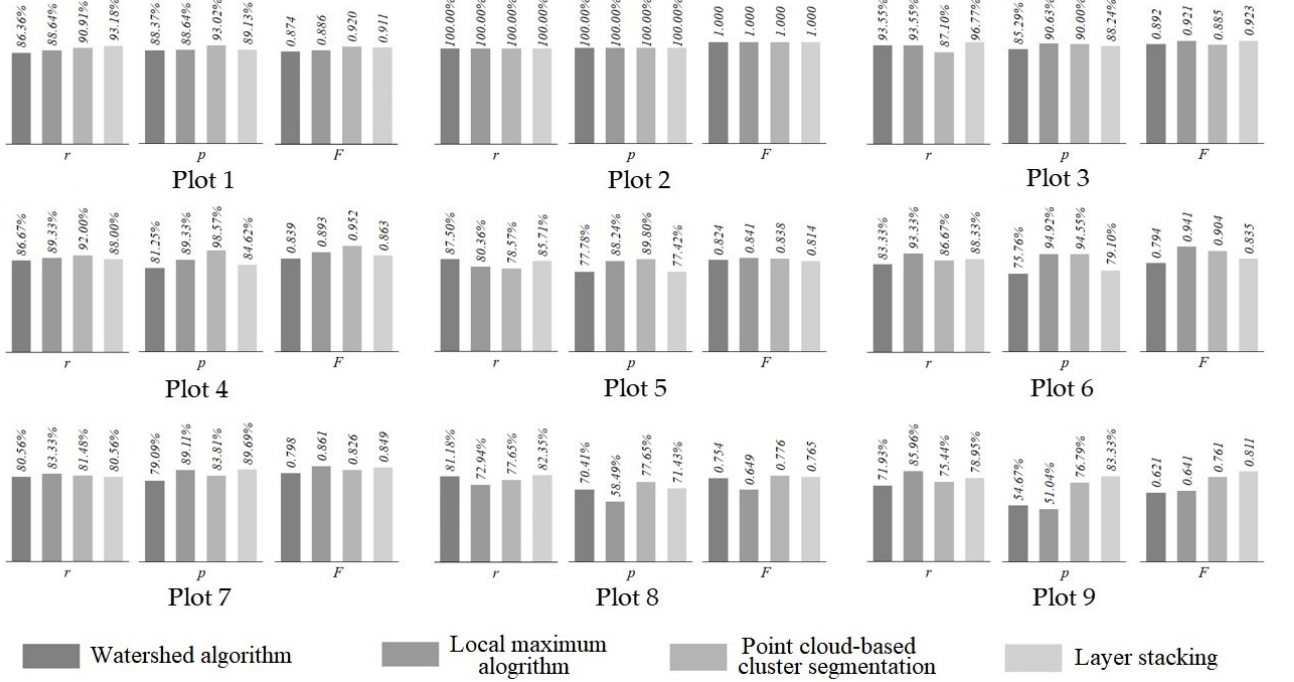
Table 2. Comparison of the Tree Height Extraction Accuracies Achieved with Different Segmenta- tion Methods.